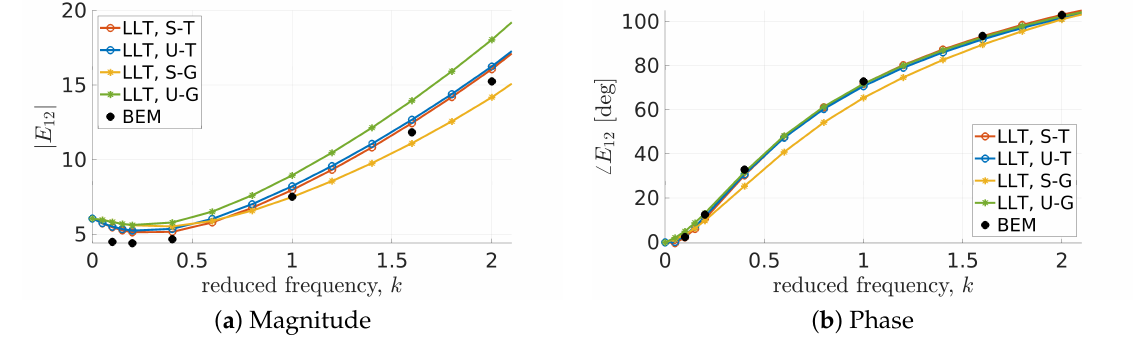
Figure 5. Transfer function E 12 ( k ) , NMV shape functions, l = 5m.